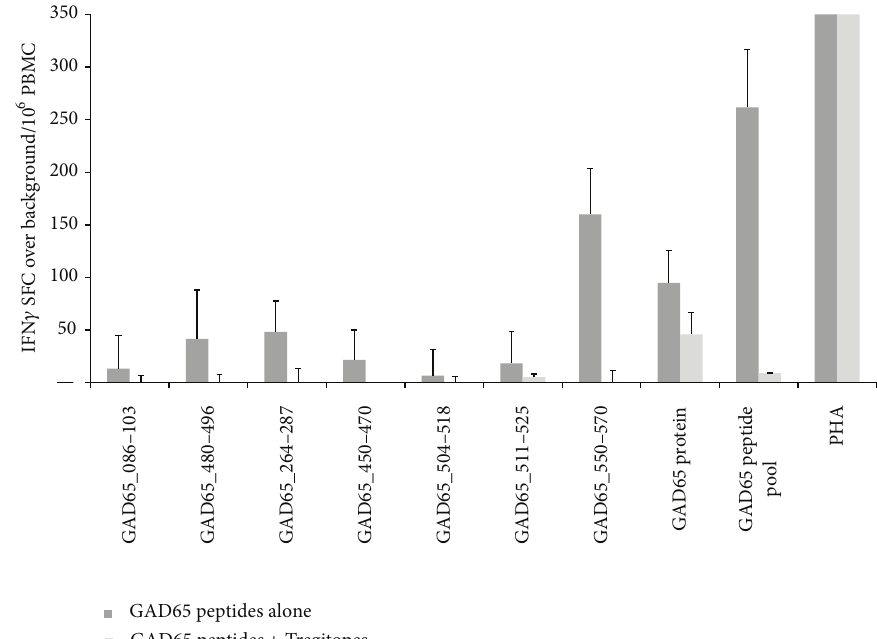
Figure 8: ELISpot results from a recently diagnosed T1D patient. Dark bars represent cells preincubated with a pool of GAD65-derived epitopes, and light bars represent cells precultured with the same pool plus Tregitope peptides. IFN 𝛾 ELISpot responses to GAD65 peptides incubated with PBMCs from a recently diagnosed subject ( < 6 months) were either low or did not meet criteria for a positive response. Tregitopes were able to suppress responses to the whole GAD65 protein and to the GAD65 peptides, individually or pooled.